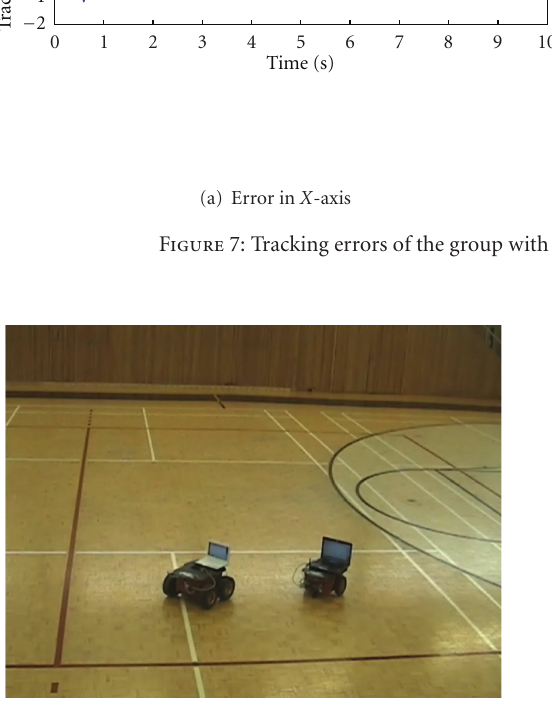
Figure 8: Pioneer 3 mobile robot test platform